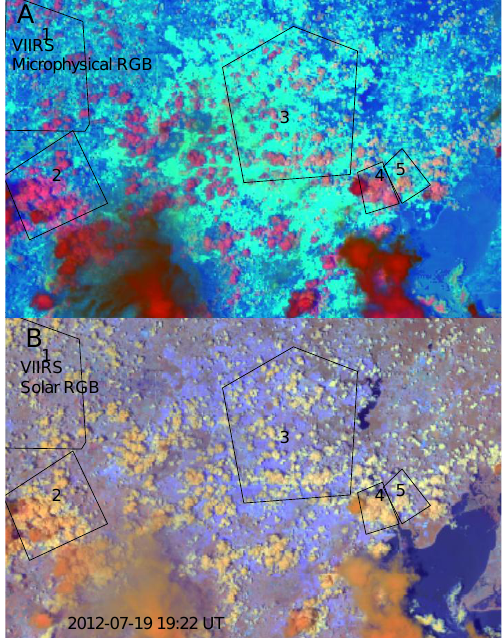
Fig. 15. Imagery of VIIRS overpass on 19 July 2012 19:22UT over Houston, Texas. Panel (A) shows the microphysical RGB, and panel (B) shows the solar RGB. Note the much brighter (i.e., with smaller r e ) clouds over the urban area compared to its surround- ings. The urban area appears as the bright blue in both panels. The wind direction is from south to north (bottom to top of the image). The areas of panels (A) and (B) are the same as 198km × 135km centered at 29.76 ◦ N, 95.43 ◦ W.